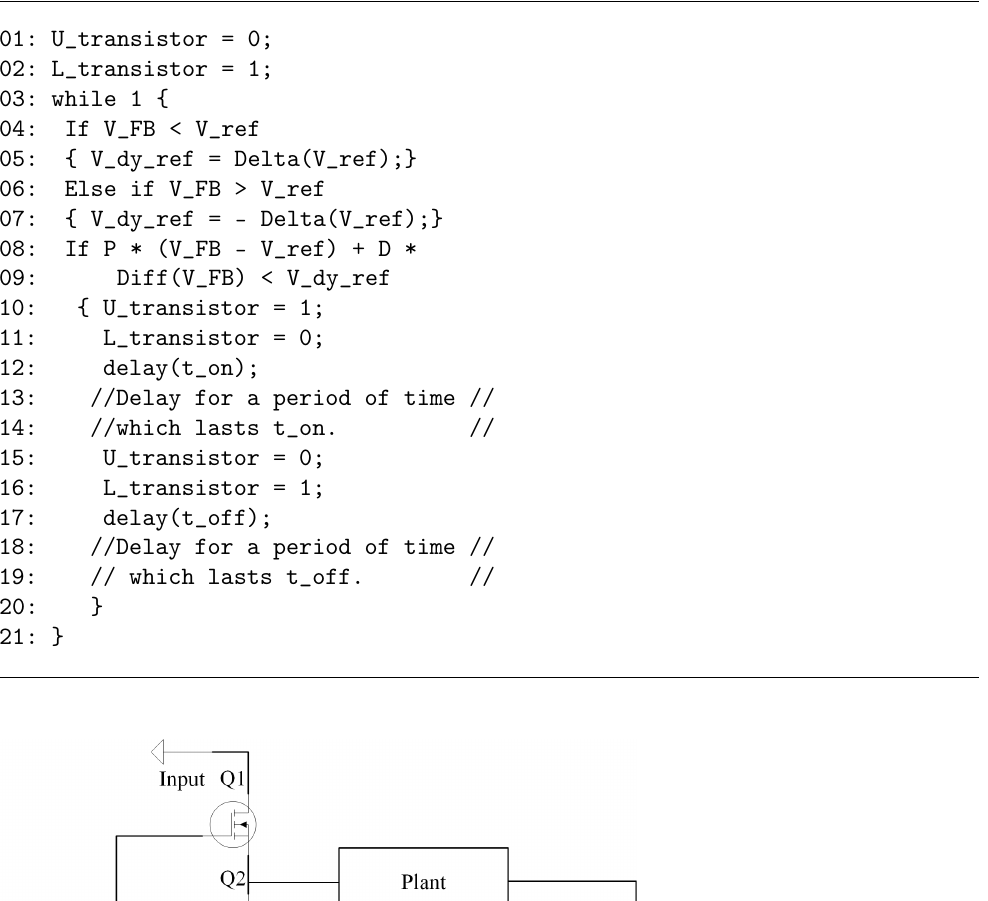
Algorithm 2 Proposed PD-COT voltage mode.